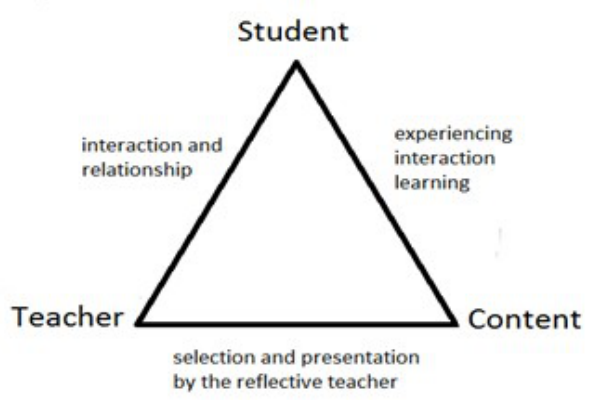
Figure 1. The didactic